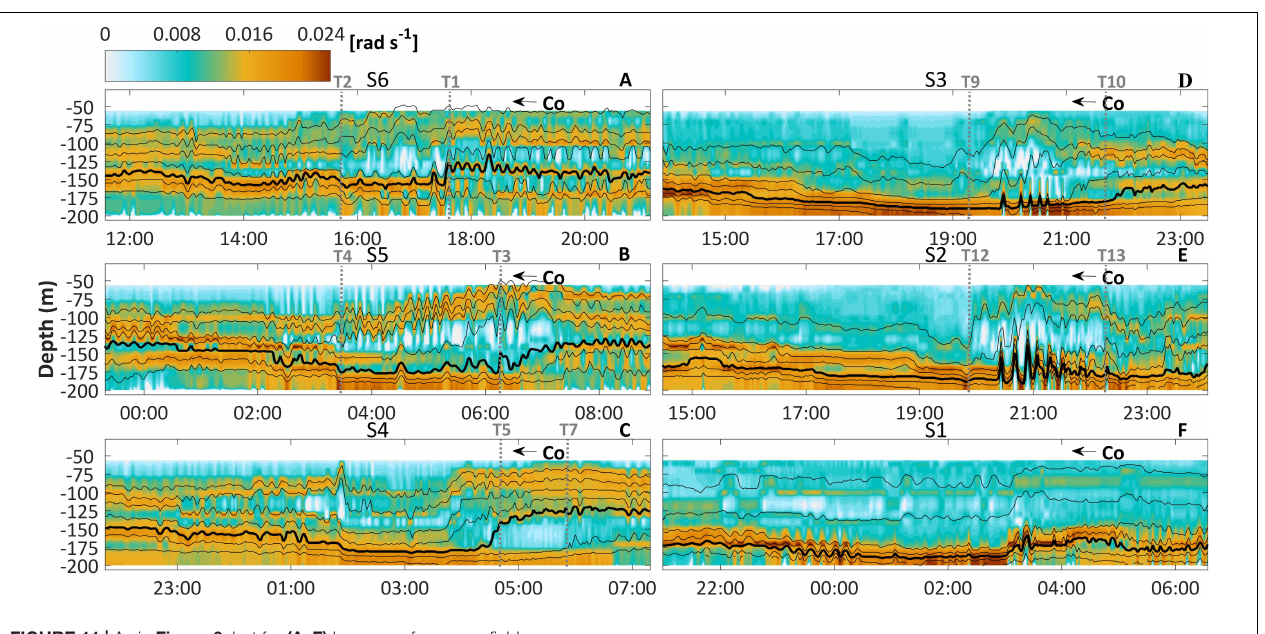
FIGURE 11 | As in Figure 6 , but for (A–F) buoyancy frequency